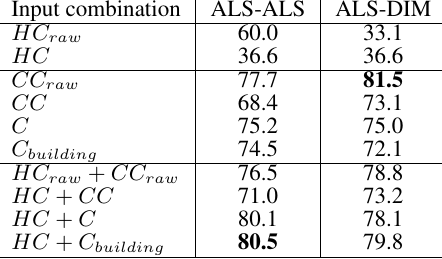
Table 1. Mean F 1 -Scores [%] calculated on object-level at τ = 0 . 5 for both test sets. Best results are marked bold.